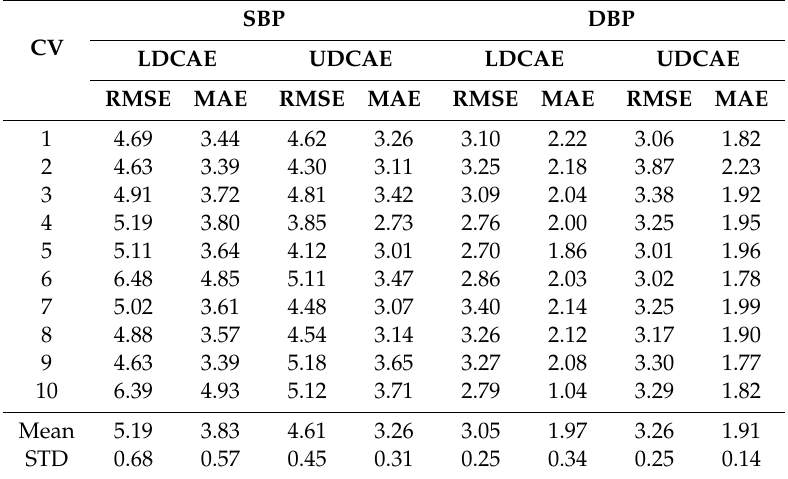
Table 2. Error Evaluations of SBP and DBP from LDCAE and UDCAE Models.